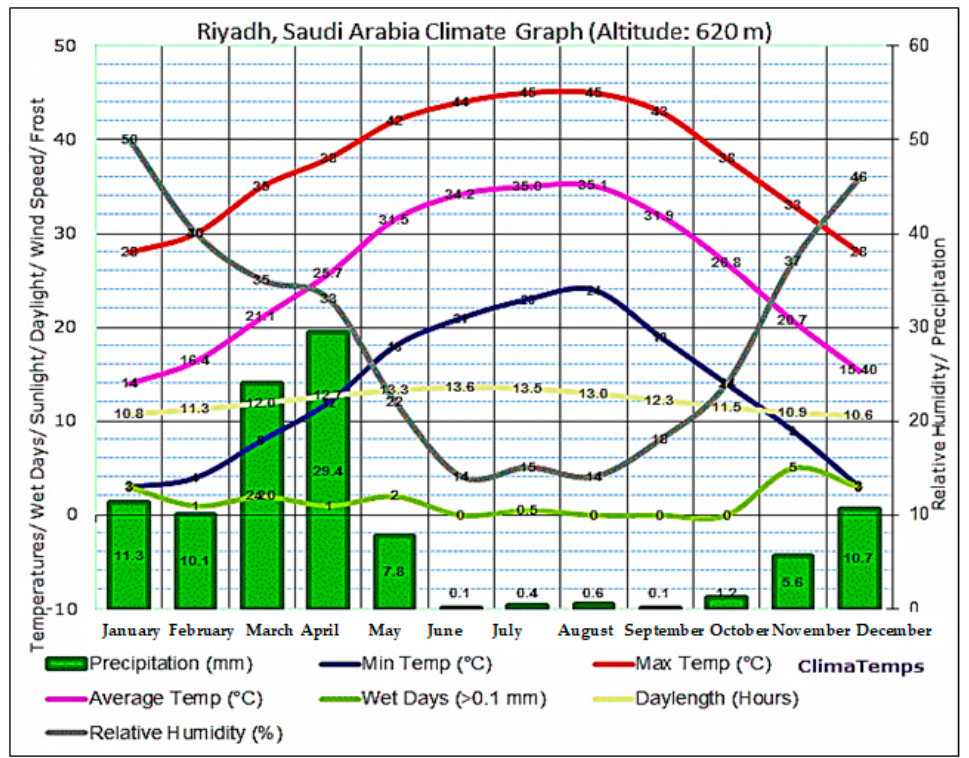
Figure 1. Climatic data of Riyadh city based on Kopean climate classification.